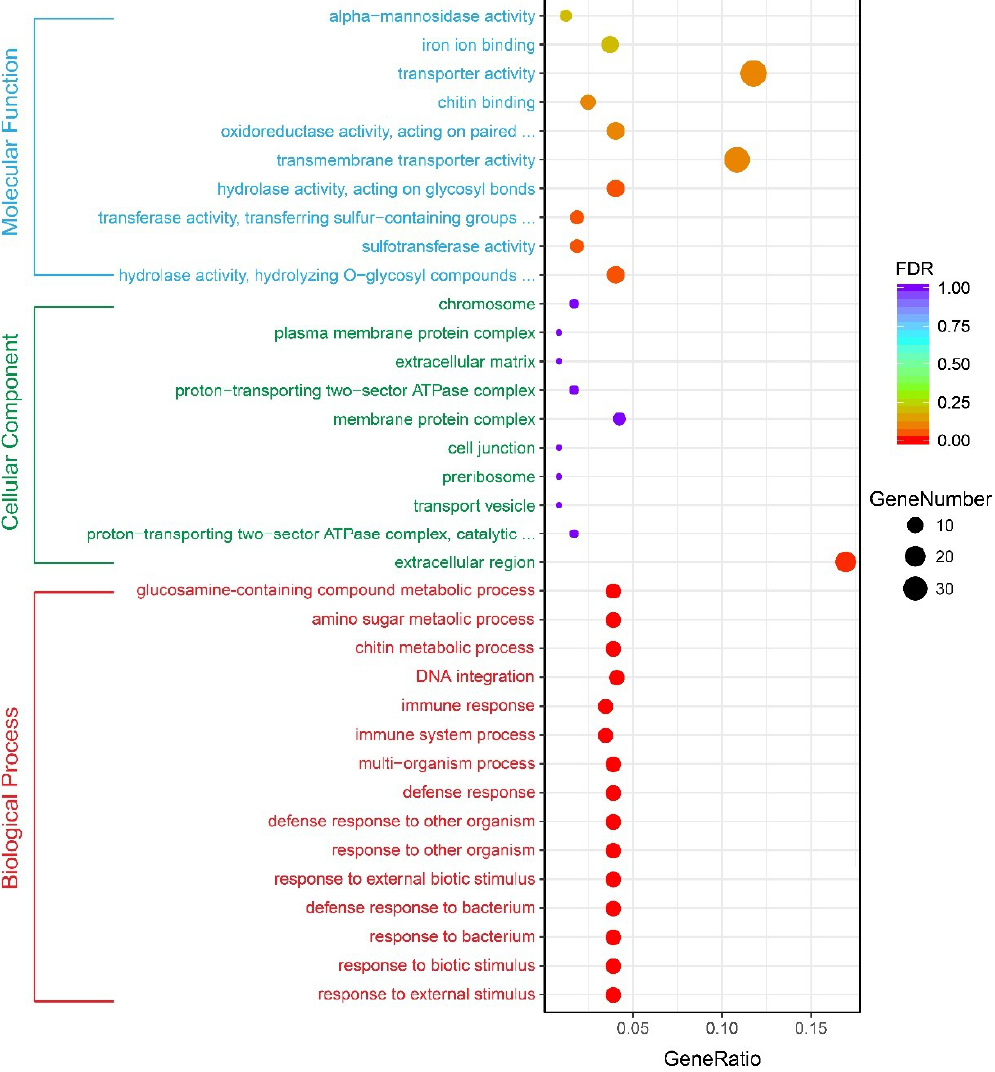
Figure 6. Gene ontology (GO) analyses of DEGs. The x -axis represents the number and percent of unigenes mapped to the indicated GO term. The y -axis is gene functional classification of GO.